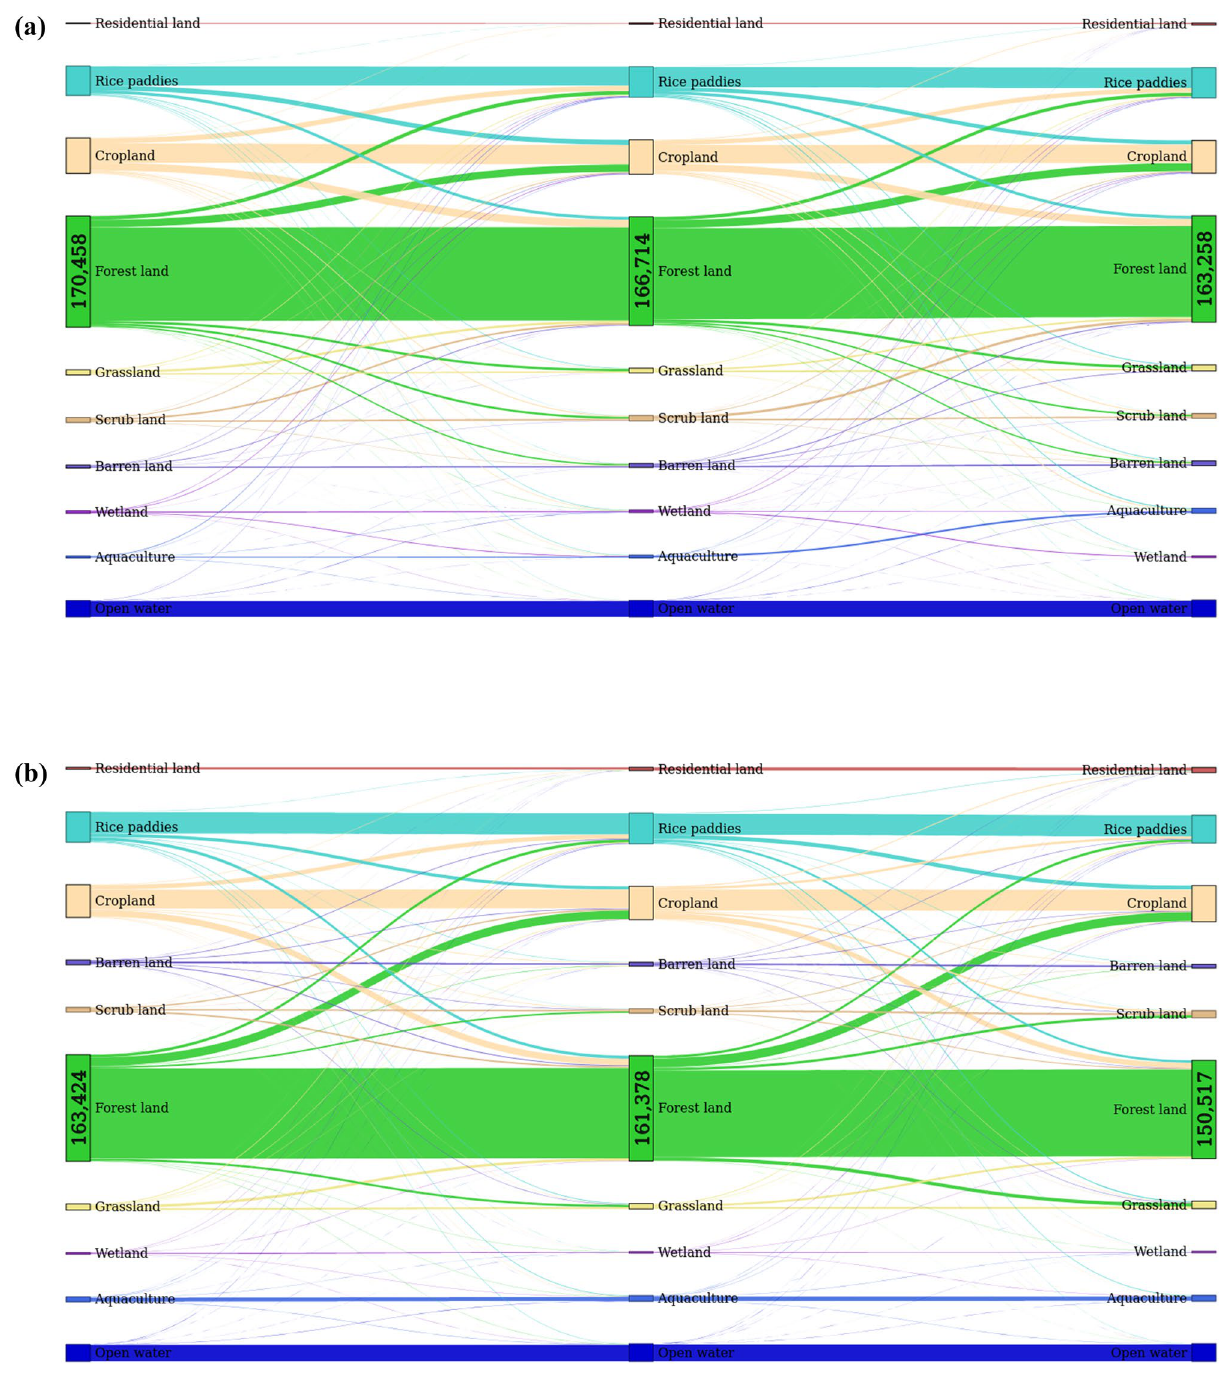
Figure 8. Temporal gross land use/cover conversions in Vietnam. ( a , b ) represent transitions among different land types from 1990 to 2010, and from 2010 to 2020, respectively. The numbers indicate the areas of forests (km 2